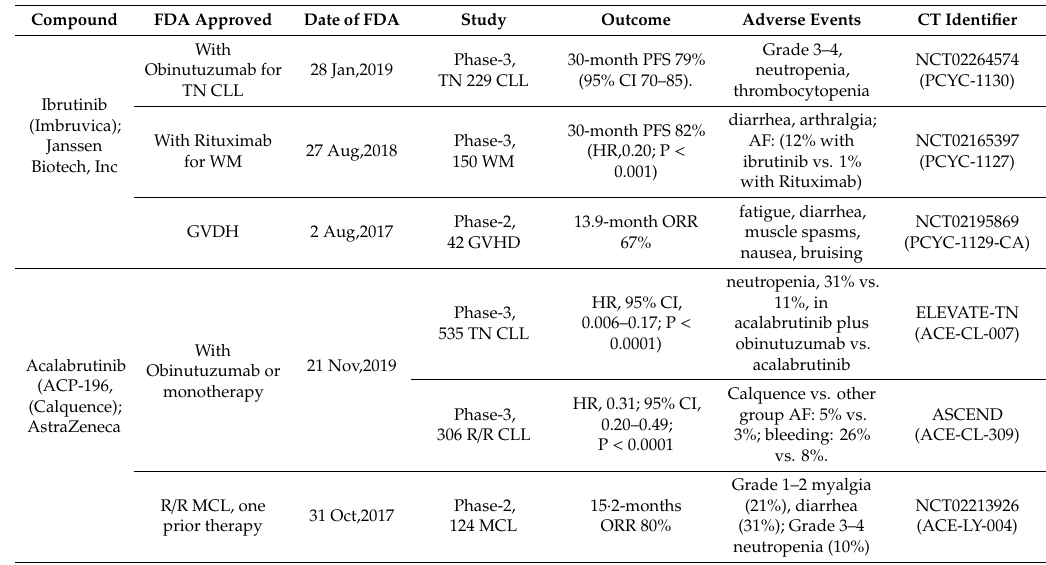
Table 2. Summary of FDA-approved BTK first- and second-generation